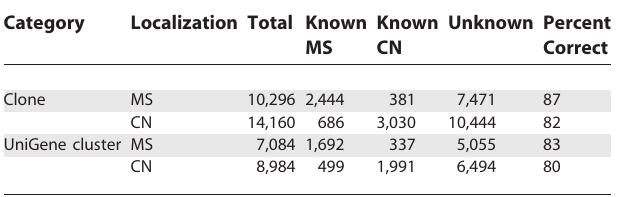
Table 1. Experimental Annotation of MS and CN